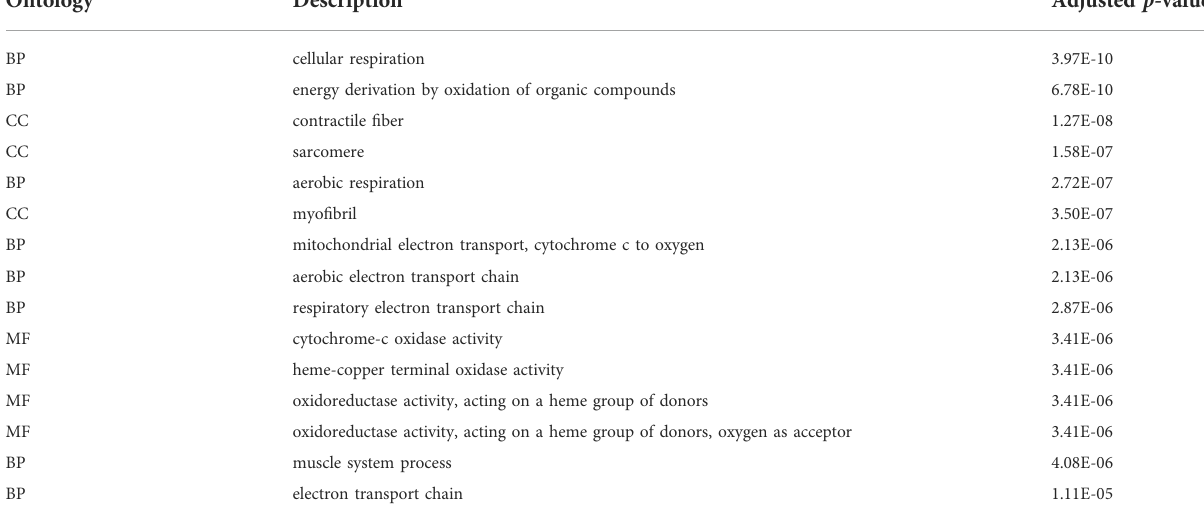
TABLE 1 GO enrichment analyses. (Only the top 15 terms are